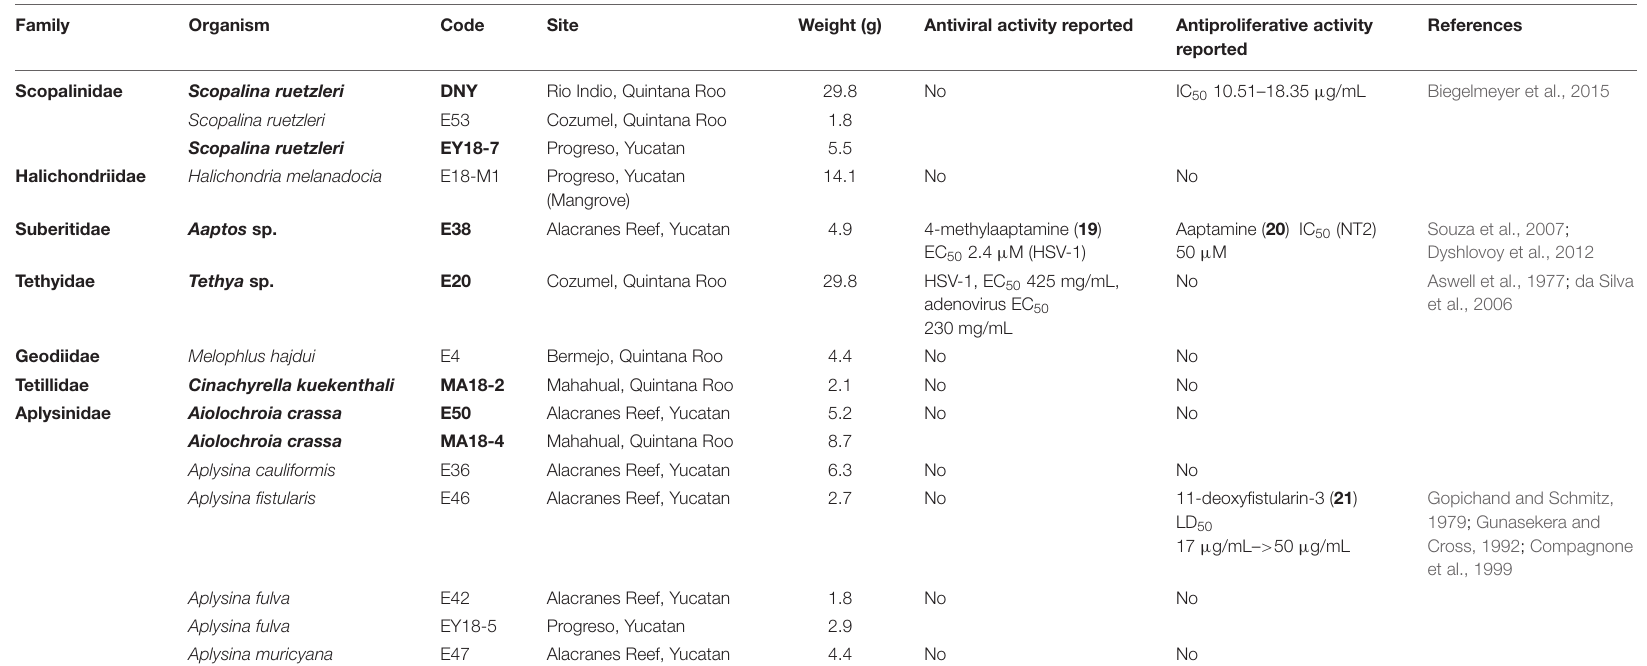
TABLE 1 | Conitnued